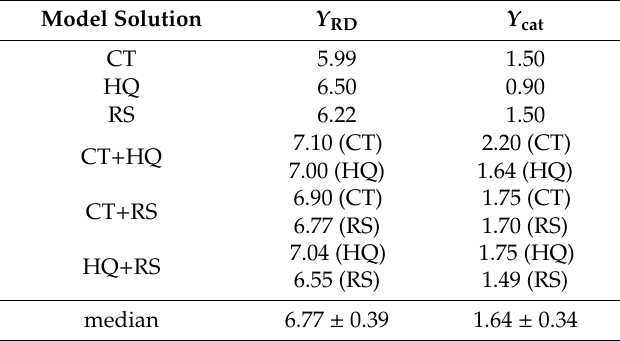
Table 2. Calculated intensification indices, Y RD and Y